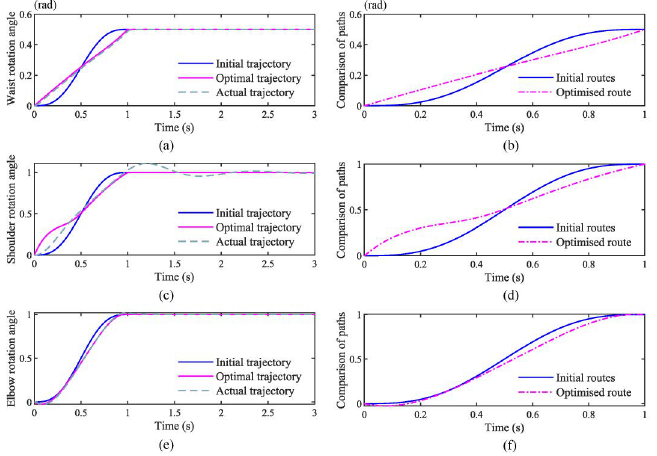
Figure 9. Trajectory parameter optimization. ( a ) Actual trajectory of the waist ( b ) Optimised route of the waist. ( c ) Actual trajectory of the shoulder. ( d ) Optimised route of the shoulder. ( e ) Actual trajectory of the elbow. ( f ) Optimised route of the